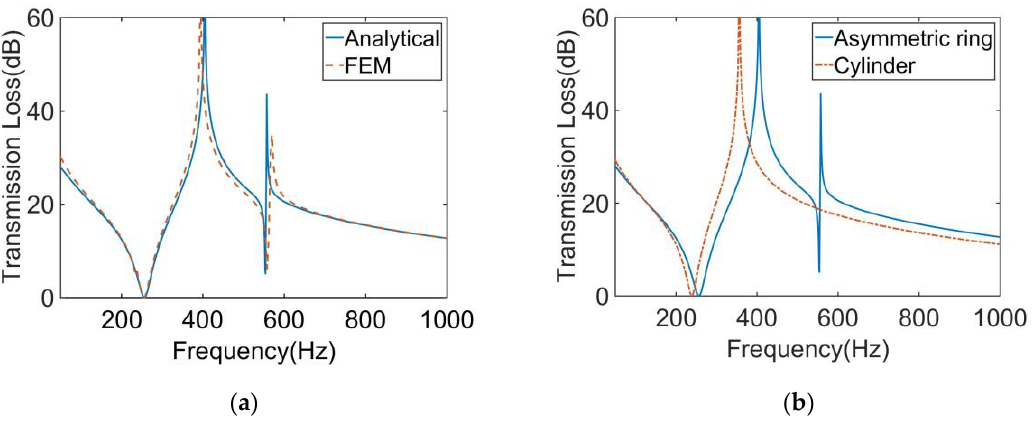
Figure 3. ( a ) Comparison of the analytical and numerical results for the STL curve of the MAM with an asymmetric ring. ( b ) Comparison of the MAMs with an asymmetric ring and a cylinder for the STL curve.